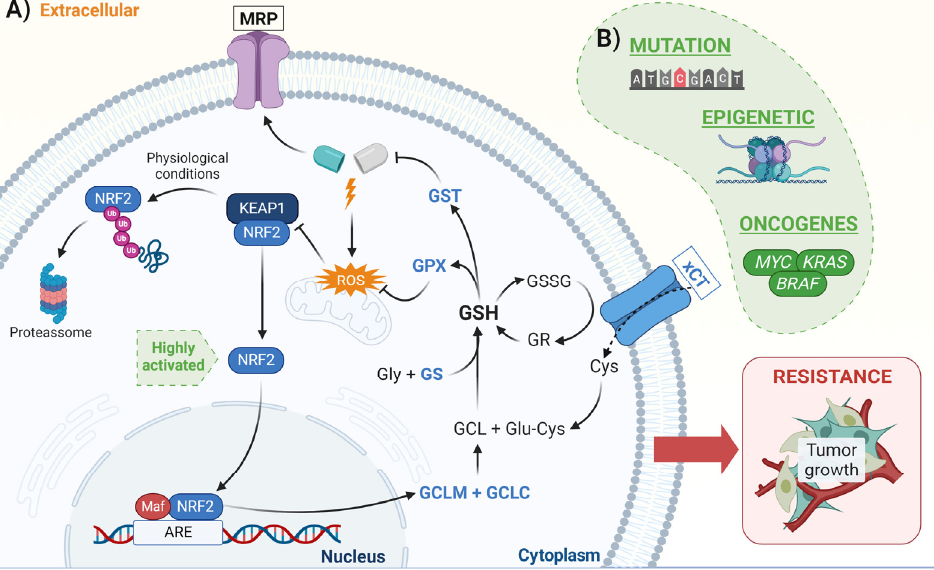
Figure 3. Drug detoxification mediated by NRF2 in cancer cells. The high activation of NRF2 promotes an increase in the GSH synthesis via the induction of GCLM and GCLC. ( A ) Once GSH is synthesized, the GST induces its binding to the chemotherapeutic drug and the GSH–drug conjugate is exported out of the cell through the multidrug resistance-associated proteins (MRPs) channel. In addition, GPX controls the ROS levels generated by the drug. These mechanisms lead to an increase in resistance to antitumor drugs in cancer cells and promote their growth and metastasis. ( B ) The green shape shows examples of mechanisms that induce NRF2 activation in cancer cells. Created with BioRender.